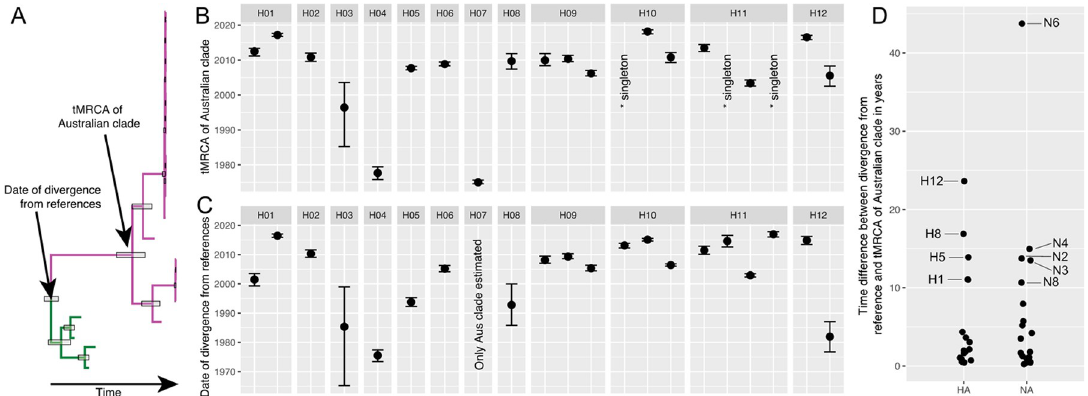
Fig 4. The time-scale of LPAIV evolution by subtype in Australia. (A) A schematic phylogeny demonstrating the differences between the tMRCA of Australian lineages and the dates of divergence from reference sequences. (B) The tMRCA distribution of contemporary Australian lineages of the HA segments and (C) dates of divergence from the reference sequences of all HA lineages. Points represent the node date and bars the 95% HPD. For segments with multiple lineages, multiple estimates have been provided. Where a novel introduction is represented by a single sequence the tMRCA was not estimated (here, represented by “ � singleton) but the date of divergence from reference sequences is shown. For H7, we did not estimate the date of divergence from the closest reference sequences. (D) The time difference between the tMRCA of the Australian lineages and the date of separation for all HA and NA segments and lineages. Lineages with time differences of more than 10 years are labelled. All HA and NA trees are presented in Figs 3 and S4–S24.